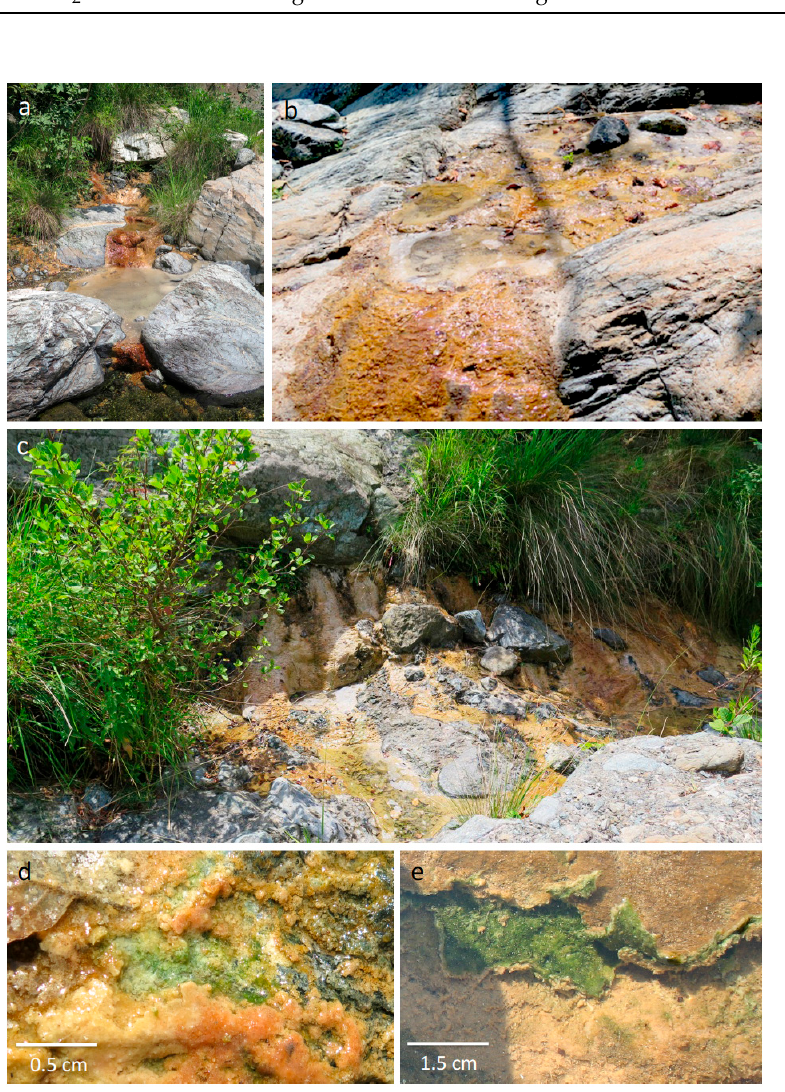
Figure 1. Cyanobacterial biofilms in sampling sites: ( a , b ) Torrente Leorne and ( c ) Torrente Branega alkaline pools. ( d , e ) Thin greenish layers, dominated by cyanobacteria, are situated below calcitic crusts. Table 1. Selected water chemistry parameters of the sampling sites (see Table S1 for a complete dataset from alkaline springs), Ler: Torrente Lerone samples; Br: Torrente Branega samples.